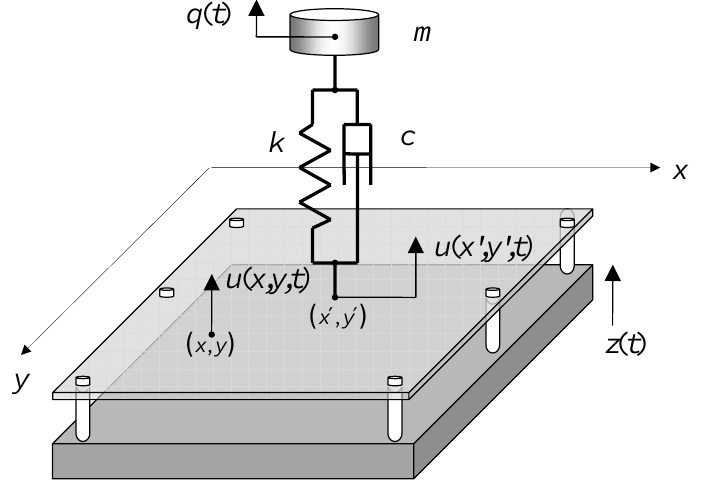
Fig. 1. Dynamic model of the PCB with dynamic